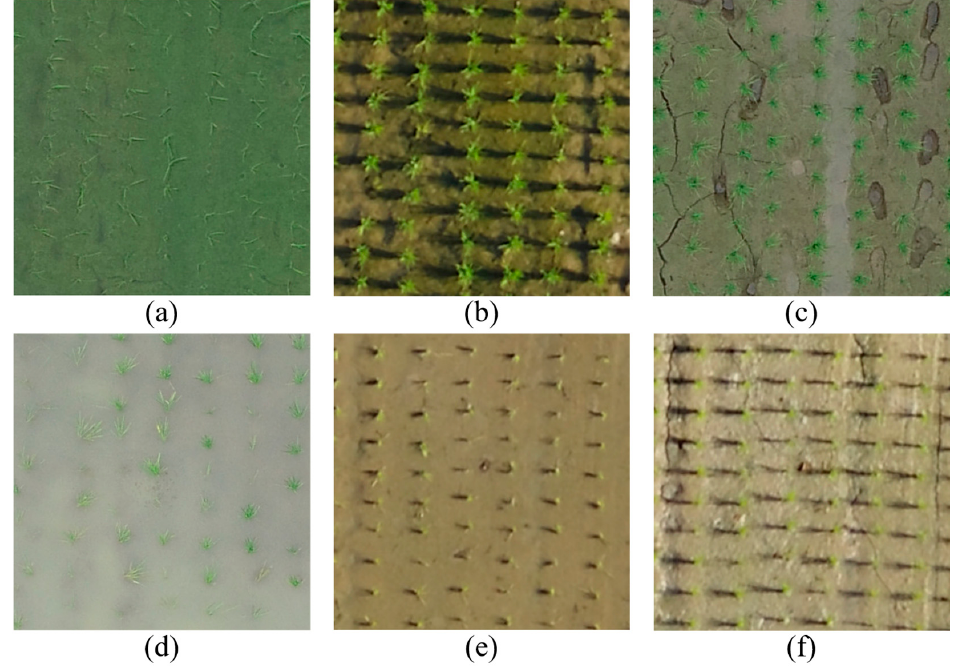
Figure 3. Examples of various environmental disturbances. ( a ) presence of algae and low contrast; ( b ) presence of algae and high contrast; ( c ) low contrast and low illumination. ( d ) low contrast, high illumination, and flooded paddy; ( e ) small seedling size and wet soil; ( f ) small seedling size and dry soil. Table 4. Information of UAV expansion data collection missions.